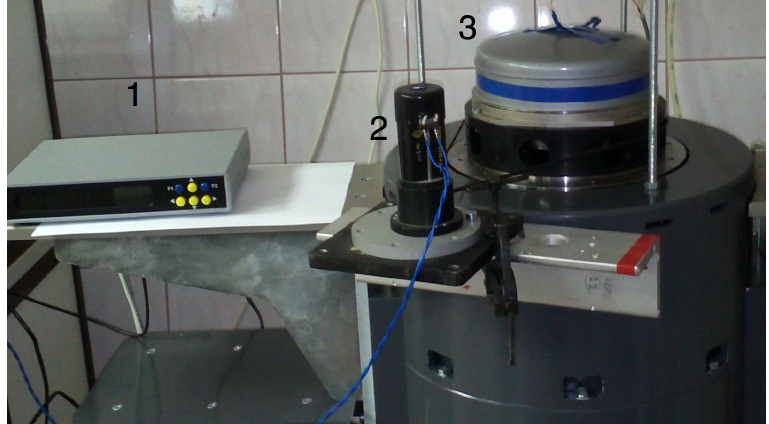
Figure2. DisplayoftheexperimentalLDGinthemodeofanon-axiscalibrationtoolofopticalencoders: 1 – optical encoder: A-205 processor, 2 – DC motor, 3 – ring